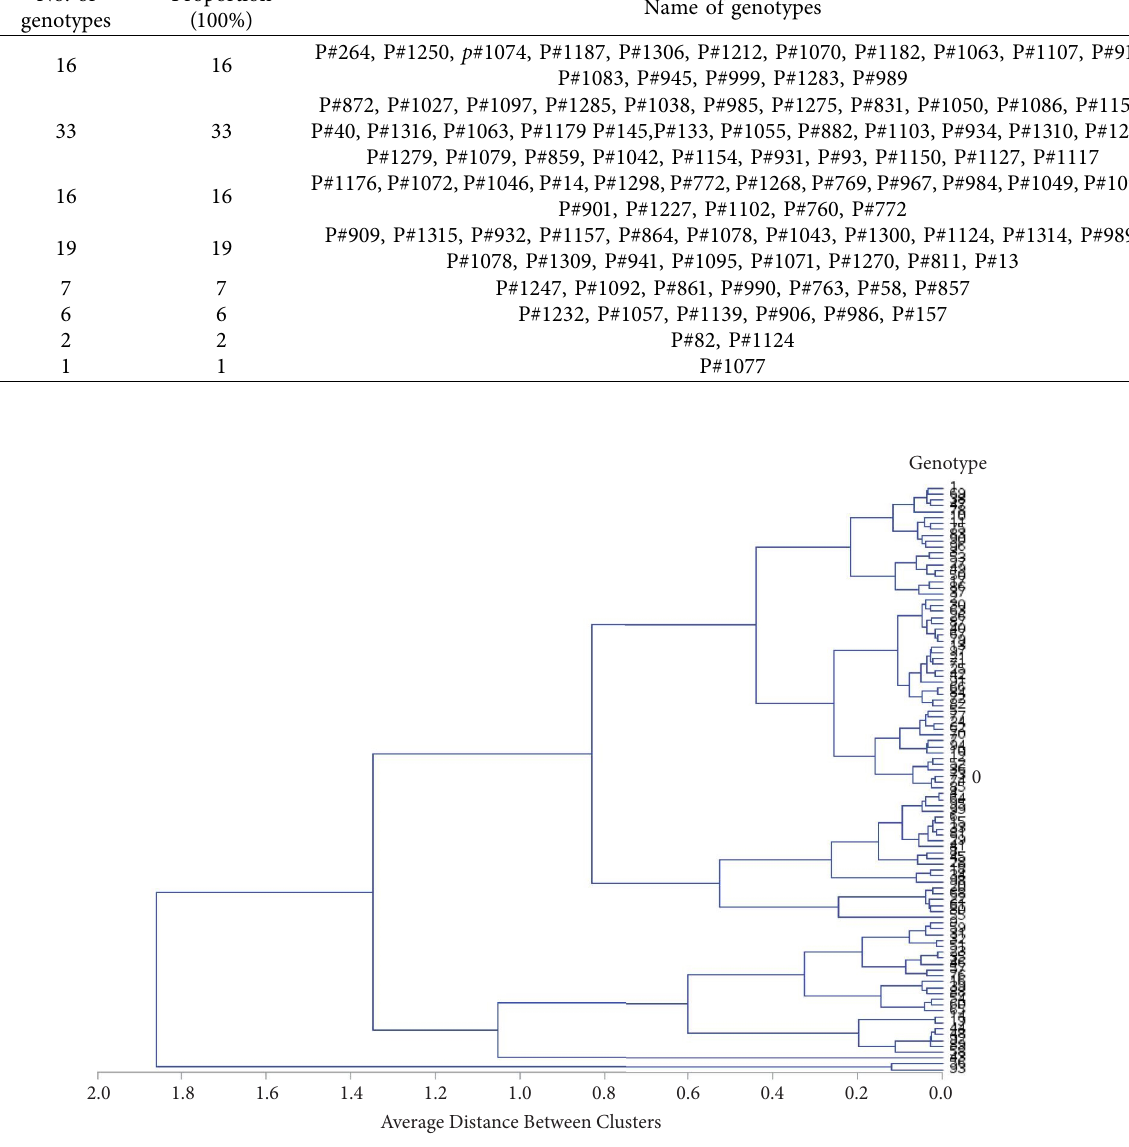
Figure 1: Dendrogram of eight clusters of traits for 100 genotypes tested at Jimma during